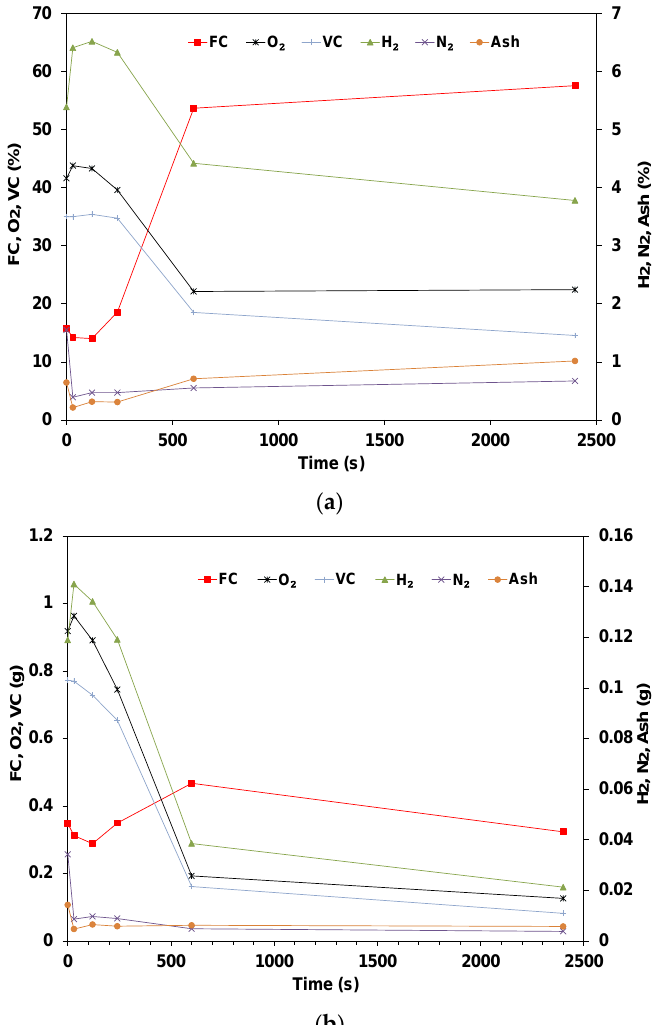
Figure 6. Elemental analysis of wood pellets at 351 °C: ( a ) in percentages and ( b ) in grams.